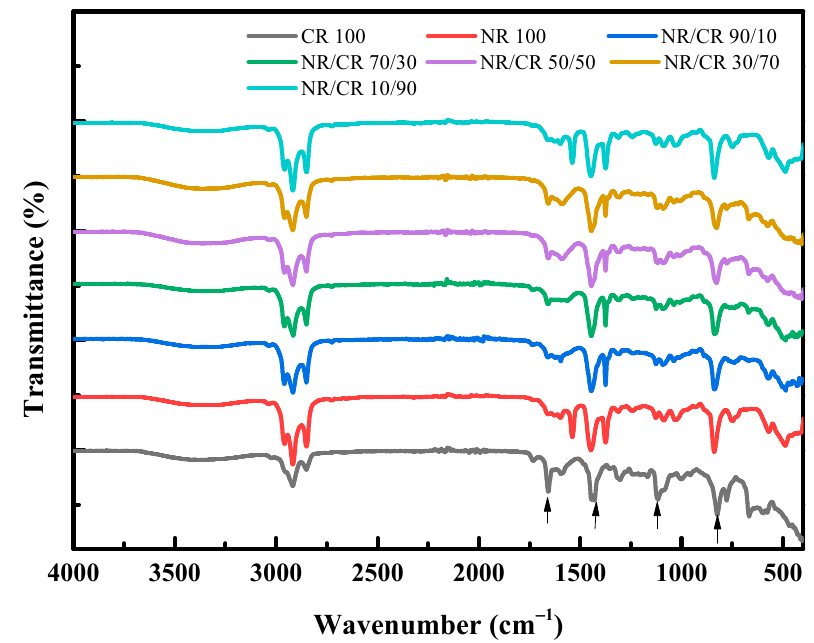
Figure 9. FT-IR curves of the NR/CR blends with different mass ratios.